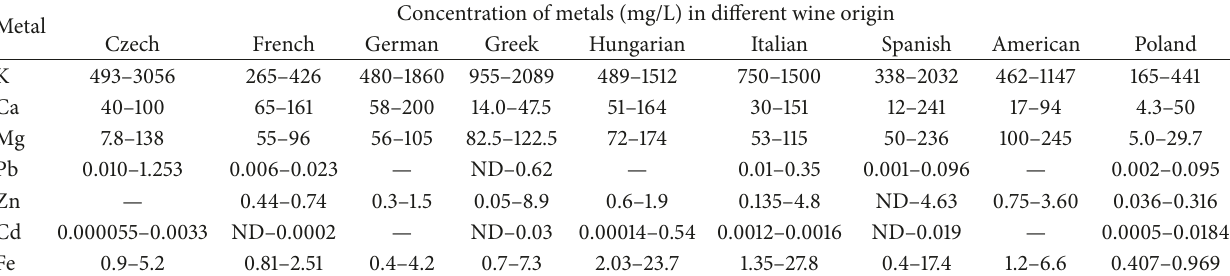
Table 7: Comparison of the concentration of metals in wines of different origin